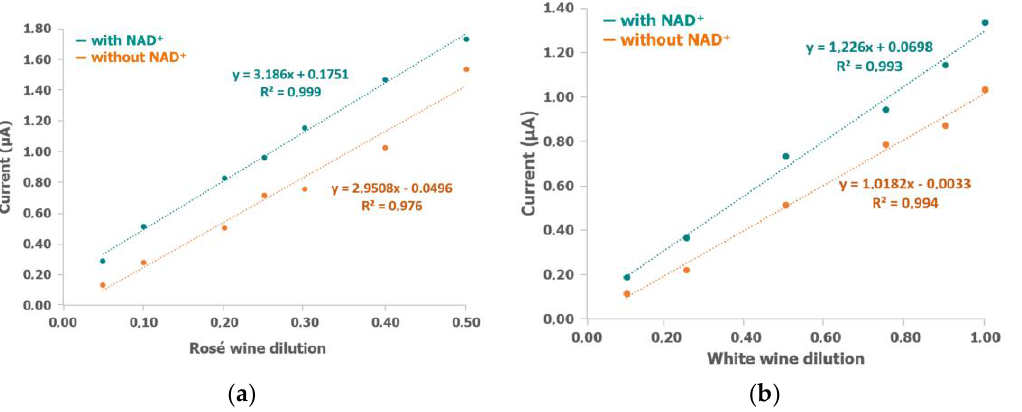
Figure 4. Calibration plot of ( a ) rosé and ( b ) white wines obtained after applying +0.40 V for 60 s with different dilutions of wine and 0.14 U/mL ALDH, 0.14 U/mL DP, with (green dots) and without (orange dots) 1 mM NAD + , 1 mM K 3 [Fe(CN) 6 ], and 0.1% BSA in 0.1 M phosphate and 0.1 M KCl buffer solution (pH 8).